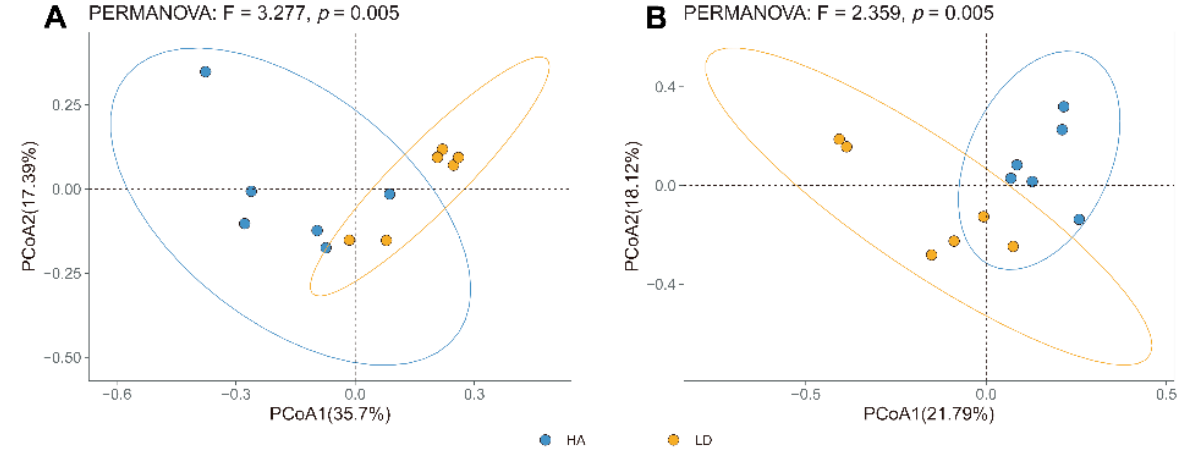
Figure 2. PCoA results ( A ) for soil bacteria and ( B ) for soil fungi based on OTU abundance. LD and HA represent the absence and presence of humic acid in diseased bayberry trees, respectively.